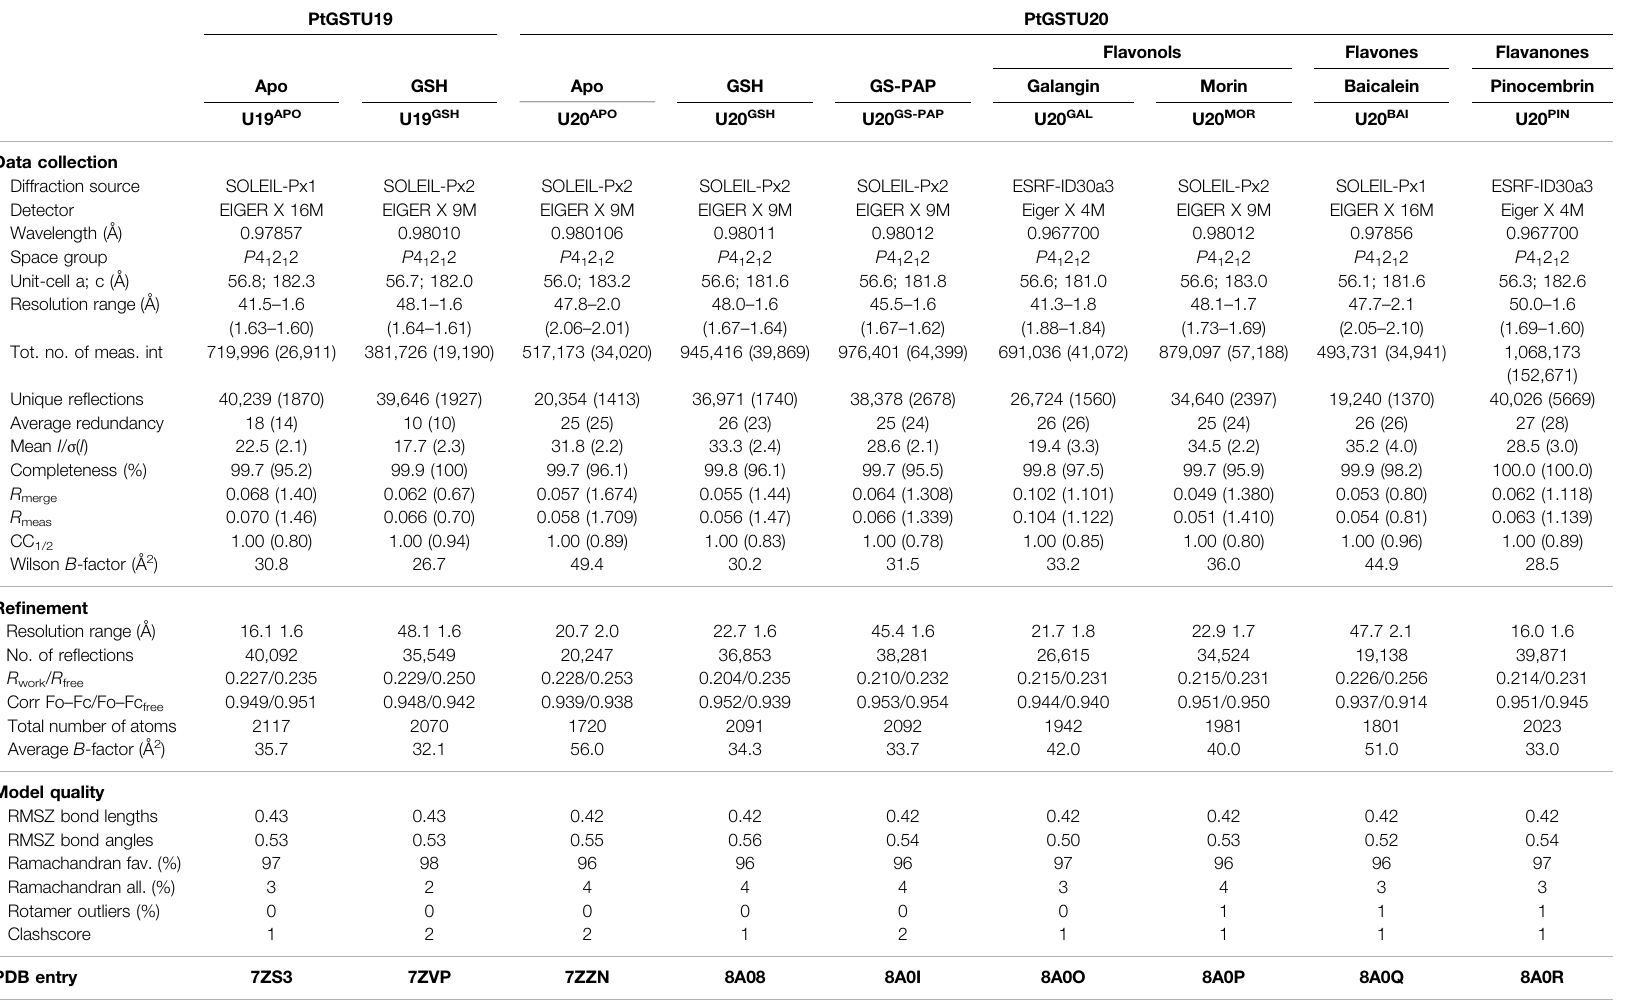
TABLE 1 | Statistics of X-ray diffraction data collection and model re fi